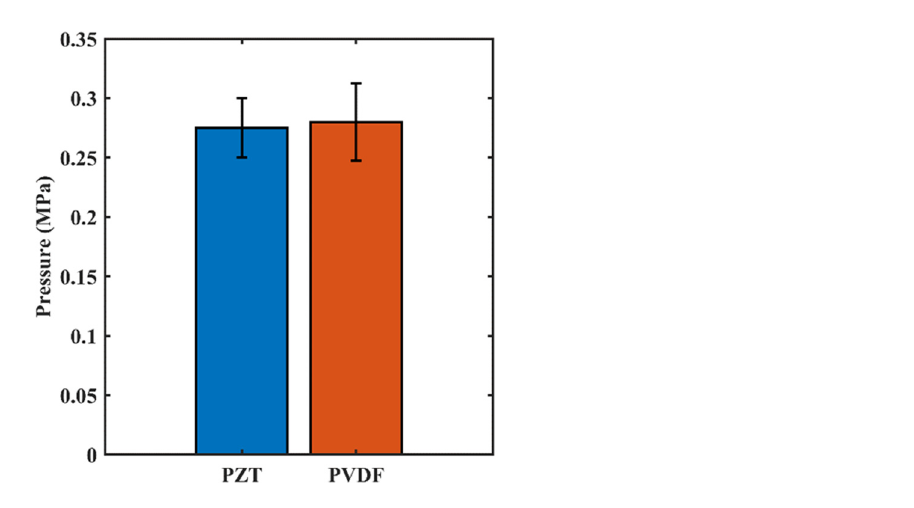
Figure 9. Pressure threshold levels of the PZT and PVDF receivers defined as sum of baseline mean and three standard deviations. Error bars indicate standard deviation of 5 tests. No statistical significance between the pressure values of PZT and PVDF was found ( p -value = 0.7924).